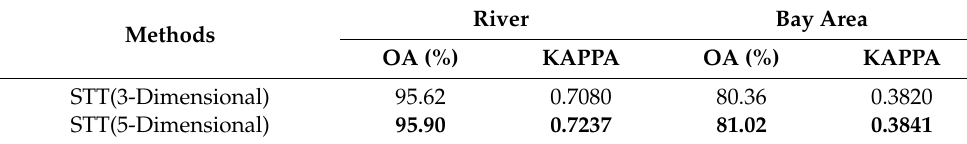
Figure 12. Ablation study of STT. River dataset ( a ) ground truth, ( b ) with 5-dimensional input patches, ( c ) with 3-dimensional input patches; Bay Area dataset ( d ) ground truth, ( e ) with 5-dimensional input patches, and ( f ) with 3-dimensional input patches. Table 3. Ablation study: STT with 5-dimensional vs. 3-dimensional input